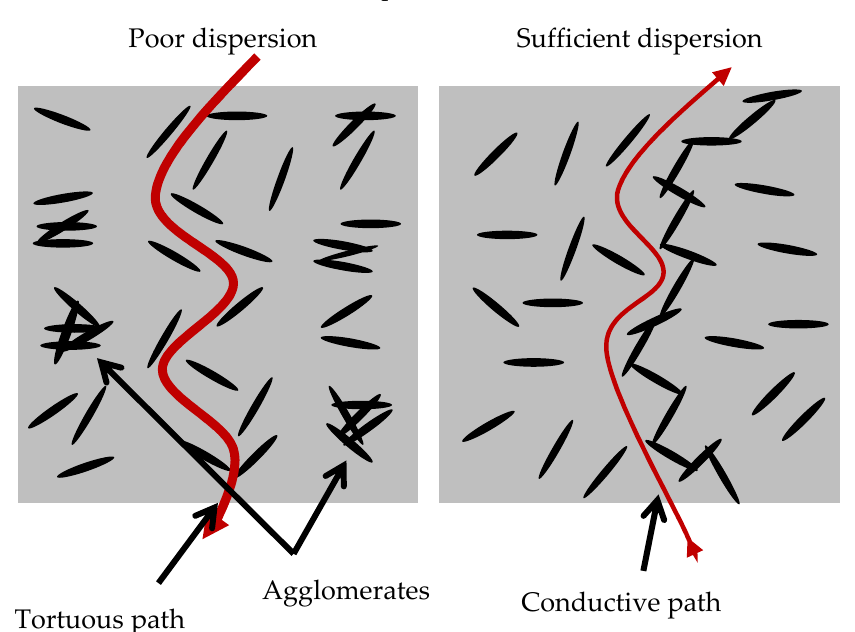
Figure 12. Electrical conductivity of GNPs–cement composites.